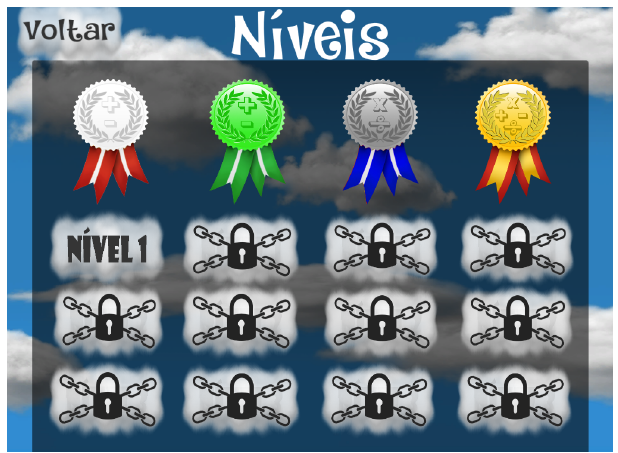
Figure 3. The medals and levels of the game.